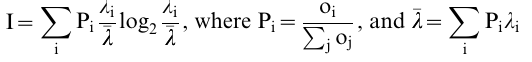
Figure S3 Validation of the seven speaker ambisonic surround sound system. (A) Schematic of the Visual and Auditory beacon tasks. Arrows indicate the random starting orientations of rats on each trial. Striped circle indicates the presence of the visual beacon. Sound icon indicates presence of auditory beacon. (B) Example paths for the two trial types. The color of each path indicates the approximate starting orientation, color coded from the arrows in a. In this and all subsequent plots, areas within the reward zone are not analyzed. (C) 2-D histogram of mean occupancy averaged across all rats. (D) 2-D histogram of normalized check rate averaged across rats. White bins received insufficient sampling. (E) Median latency and distance to reward in visual (V) and auditory (A) tasks. Effect of trial type: t =2.453, p = 0.070 and t =3.945, p = 0.0169, respectively; A vs. AV and V, p , 0.05, N= 3. (F) Sound intensity (dB) verse distance from a sound source in VR and RW. (G) Sound intensity (dB) of a